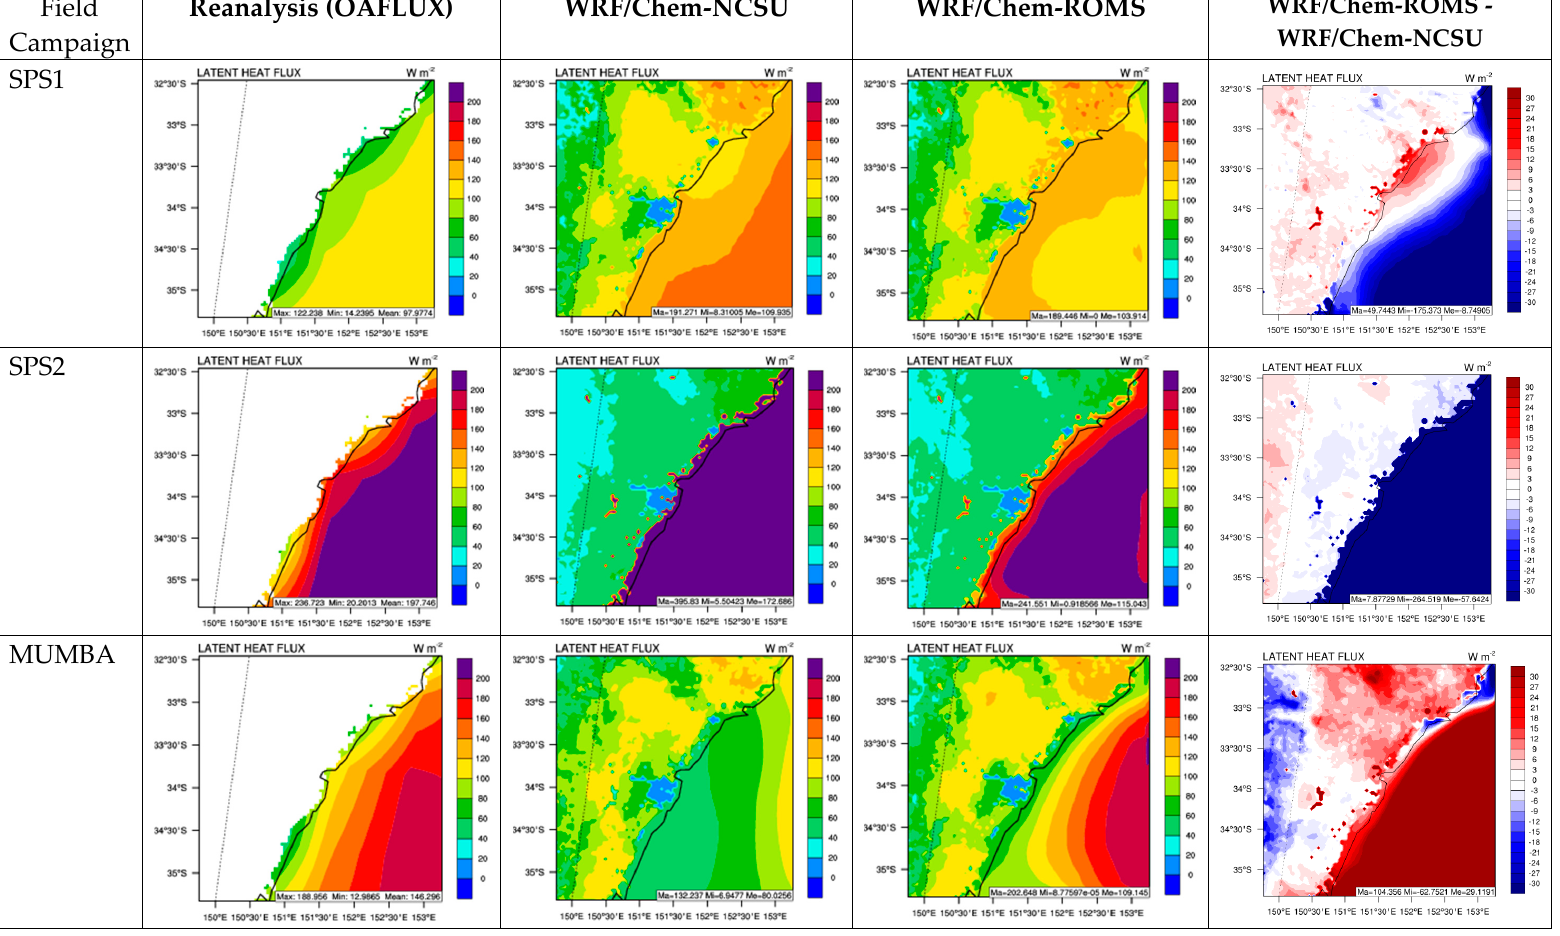
Figure 3. Observed and simulated LHF over the Greater Sydney (d04). Two sets of simulation results at 3m km are compared, one from WRF/Chem-NCSU and one from WRF/Chem-ROMS.